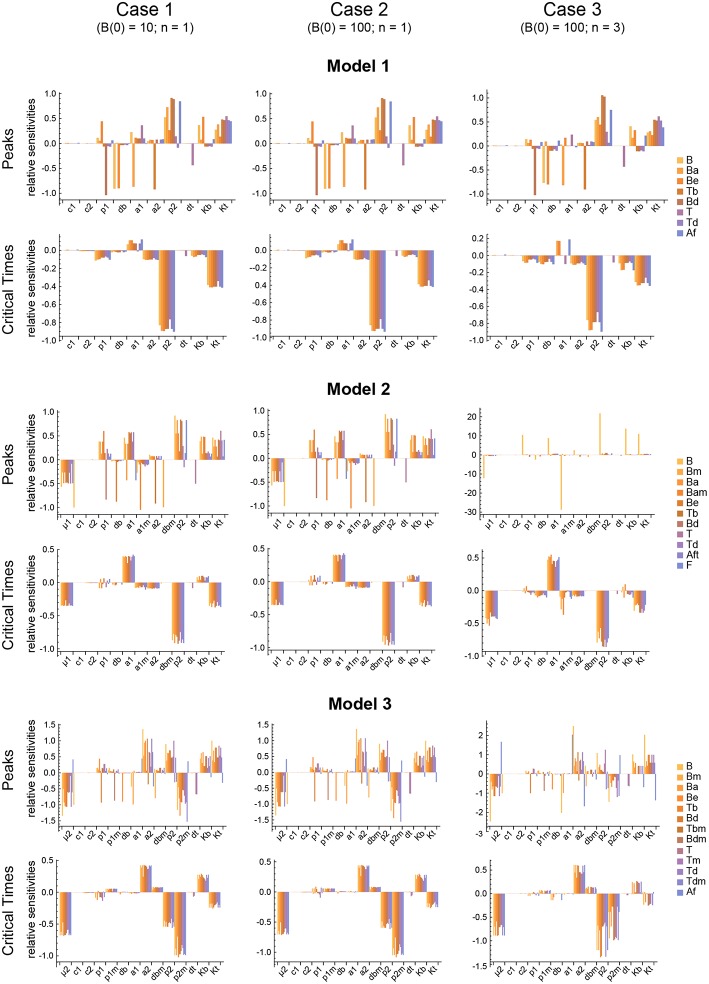
Local parameter sensitivity analysis of the three models. Histograms of the relative sensitivity of the peaks and critical times of all model variables with respect to each parameter are shown. Upper two panels correspond to Model 1, middle panels to Model 2, and lower panels to Model 3. Left side panels (case 1), center panels (case 2), and right side panels (case 3) of the three models show the results, respectively, for B(0) = 10 and n = 1, B(0) = 100 and n = 1, and B(0) = 100 and n = 3 (see text for details). Representative results from a single set of parameter values are shown. Parameter values used were the same as in Figure 3 for Model 1, Figure 4 for Model 2, and Figure 5 for Model 3.